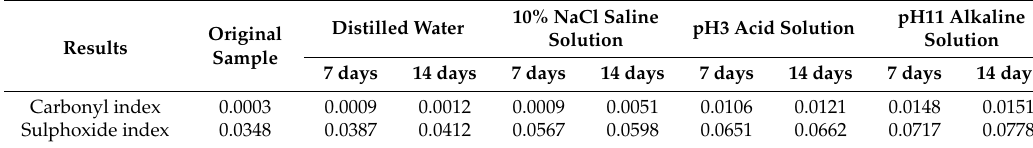
Table 3. Group indices of 70 # asphalt before and after water solute immersion.